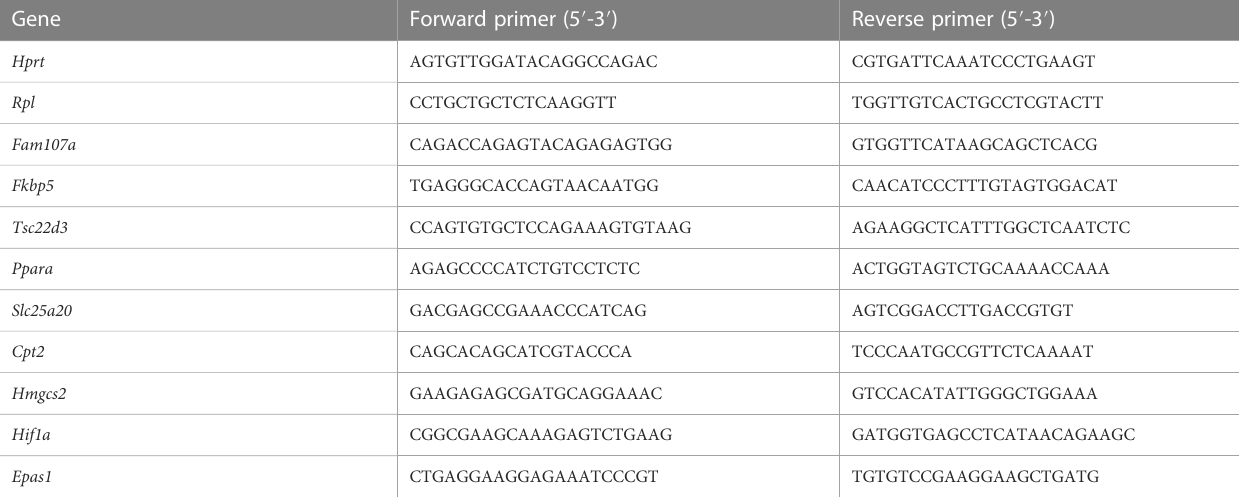
TABLE 1 Primer sequences used for